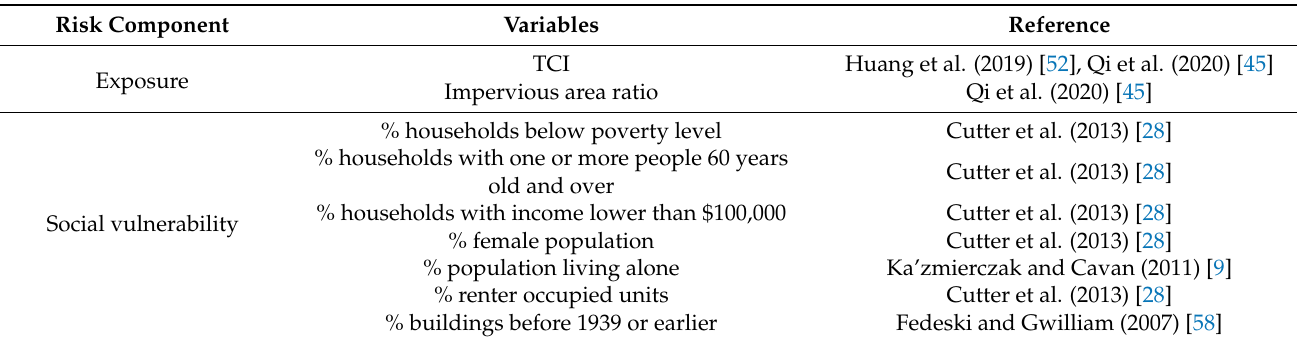
Table 1. The explanation of urban pluvial flood risk